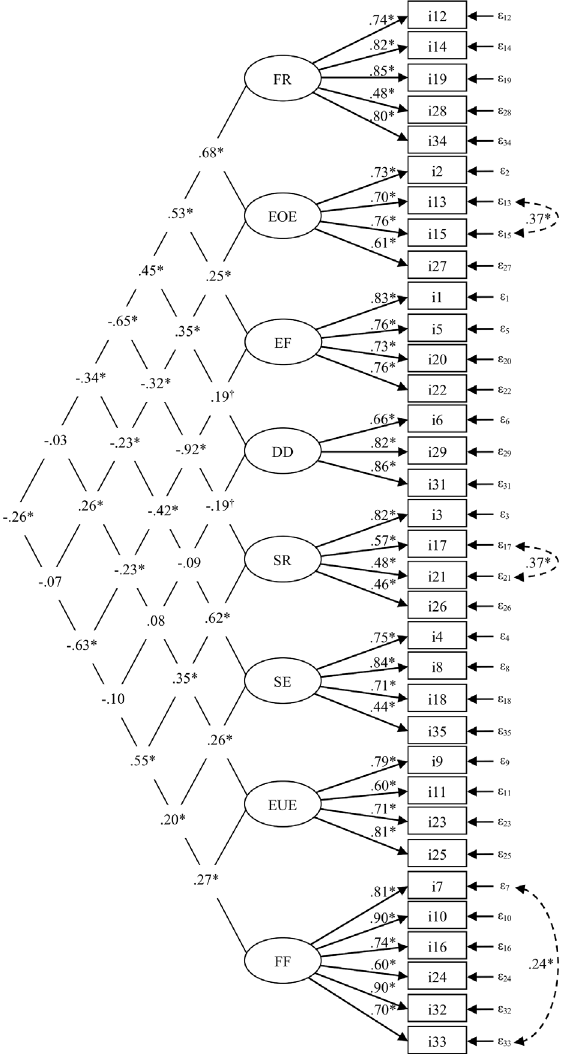
Fig 1. A Confirmatory Factor Analysis of the Child Eating Behavior Questionnaire (CEBQ). The CEBQ eight factors: Food Responsiveness (FR), Emotional Overeating (EOE), Enjoyment of Food (EF), Desire to Drink (DD), Satiety Responsiveness (SR), Slowness in Eating (SE), Emotional Undereating (EUE) and Food Fussiness (FF). Item 30 was dropped as it had a factor loading < 0.4 and three pairs of error terms were allowed to correlate. The model shows acceptable fit to data, χ 2 (496) = 1102, p < 0 .001; TLI = 0.91; CFI = 0.92; RMSEA = 0.05 (90% CI: 0.047 – 0.055) and SRMR = 0.06). † p < 0.05; * p < 0.001. The estimates on the left side in the figure stand for correlations between the factors and the estimates on the right side of the figure stand for factor